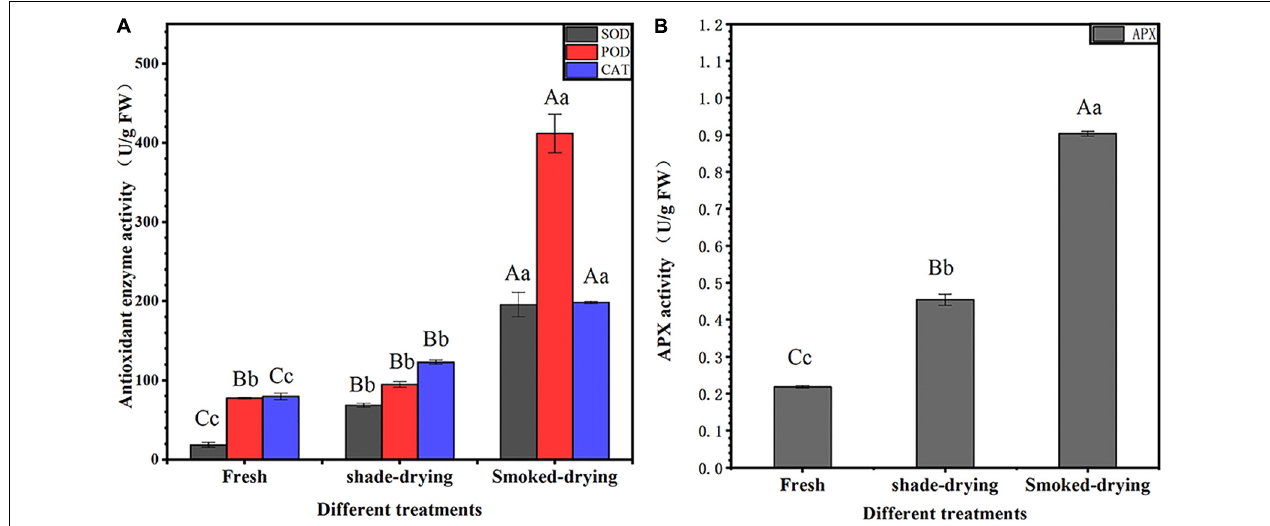
FIGURE 2 | Activity of antioxidant-related enzymes. (A) SOD, POD, and CAT activity; (B) APX activity. The error bars represent the means ± SE ( n = 3). The degree of freedom between groups is 8. Perform ANOVA on SOD, POD, CAT, and APX activities, respectively. Different letters indicate a significant difference (capital letters p < 0.01, small letters p <